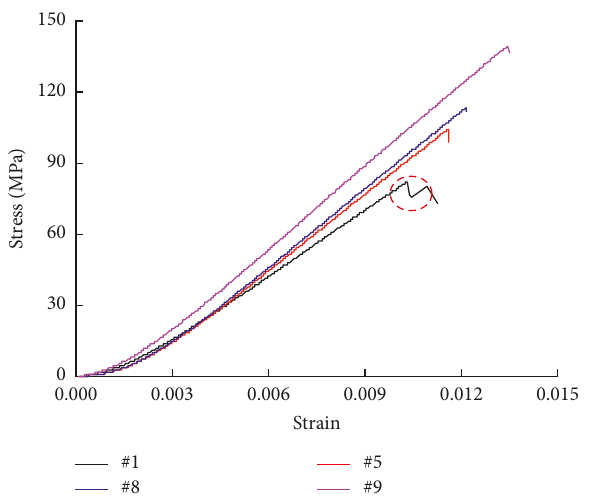
Figure 4: Stress-strain curve of Group 2 with initial damage.